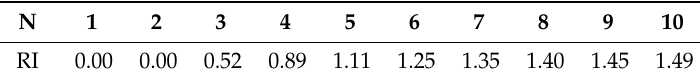
Table 2. Random Consistency Indexes for different matrix